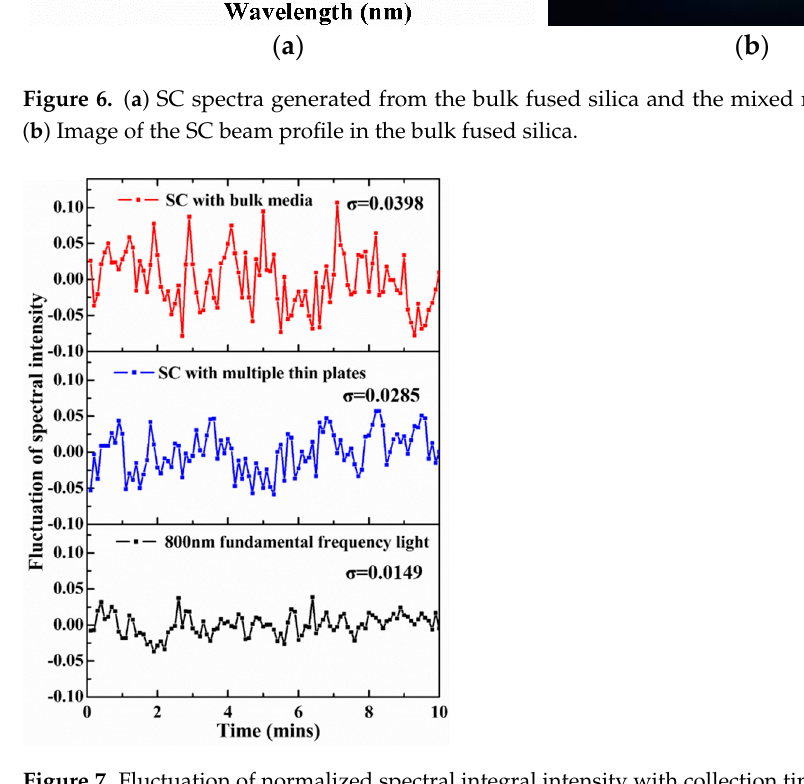
Figure 7. Fluctuation of normalized spectral integral intensity with collection time. σ is the standard deviation of normalized spectral integral intensity.